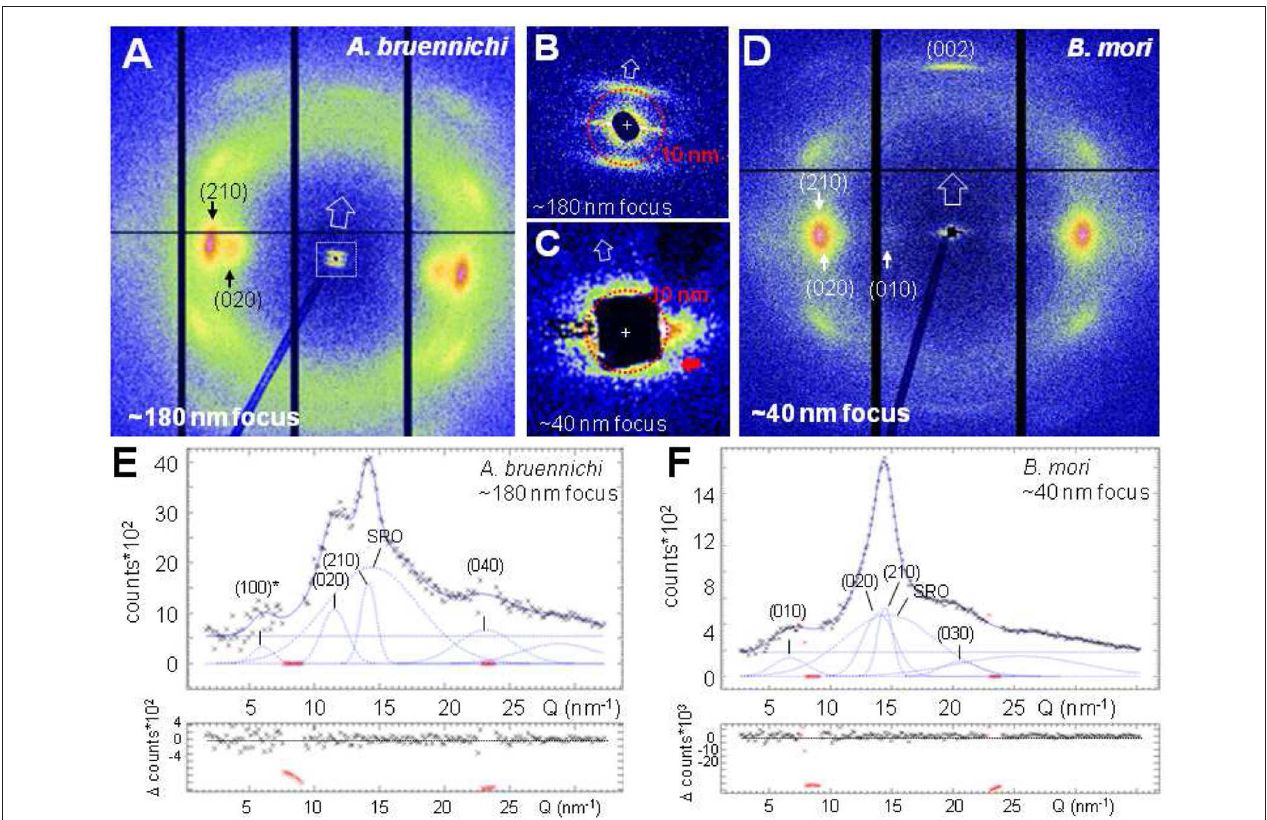
FIGURE 2 | NanoXRD patterns of silk fibers. 20 patterns were averaged for the ∼ 180nm focus and 201 patterns for the ∼ 40nm focus. (A) A. bruennichi’s MaS fiber pattern for 190 nm hor × 170 ver nm 2 (fwhm) focus. Black vertical and horizontal lines correspond to inactive detector areas. (B) SAXS-range for ∼ 180nm focus. Open arrow along (meridional) fiber axis. (C) SAXS-range for ∼ 40nm focus; red arrow points to correlation peak at the edge of the beamstop. (D) B. mori’s pattern for 50 hor × 35 ver nm 2 (fwhm) focus. (E,F) Equatorial intensity profiles (black crosses) and fitted curves by Gaussians for Bragg/SRO peaks; 0-order polynomial for random background ( Q = 2 π /d; d : lattice spacing); individual Gaussians shown after subtraction of polynomial. Lower plots: differences of observed minus simulated profiles. Inactive detector areas (in red) masked for the fits. Millers indices correspond to poly(L-alanine) or poly(L-alanylglycine) lattices (Marsh et al., 1955a,b). The forbidden (100)* reflection is discussed in Riekel et al. (2017).